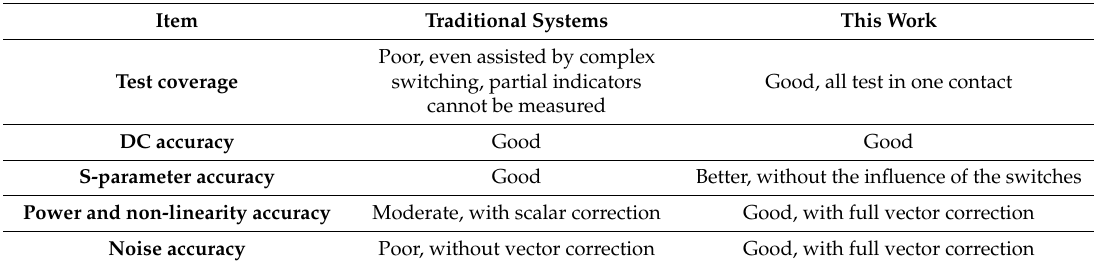
Table 7. Test coverage and accuracy comparison.